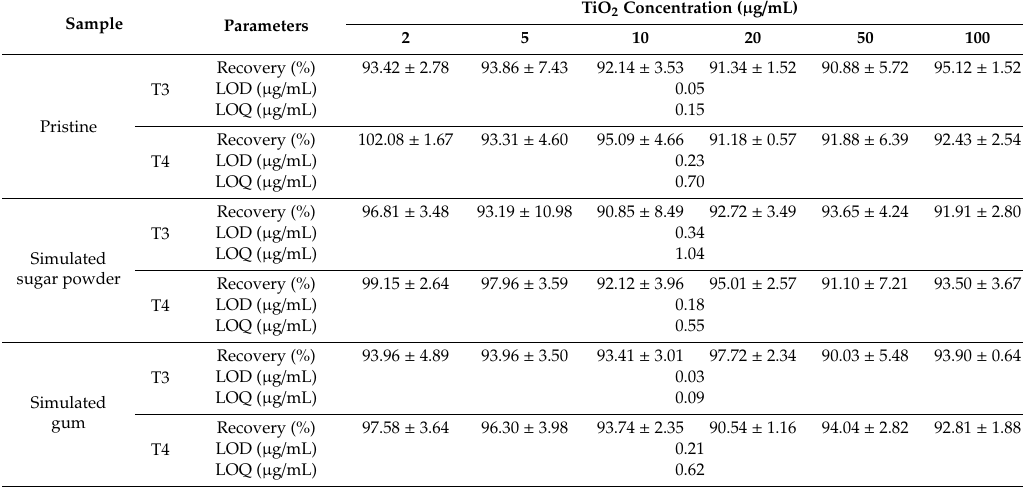
Table 4. Analytical recovery, limit of detection (LOD), and limit of quantification (LOQ) of quantitative analytical procedure for TiO 2 .